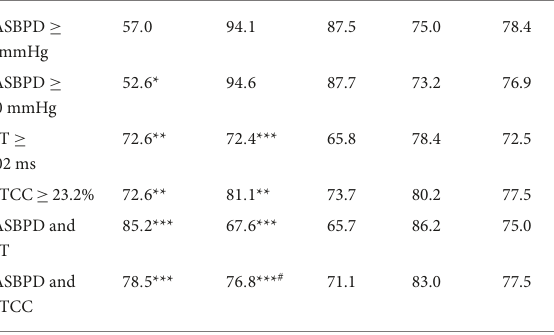
TABLE 3 Sensitivity and specificity of IASBPD, UT, and UTCC alone and their combinations in screening SA. Sensitivity Specificity Positive Negative